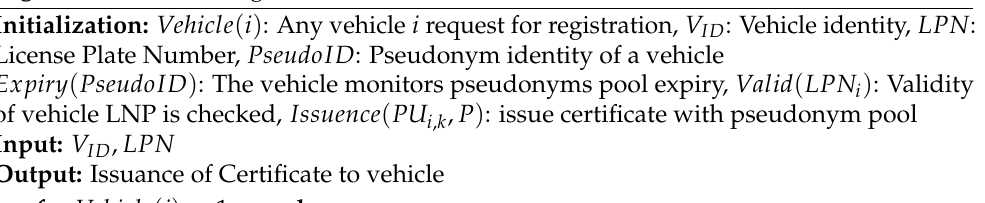
Algorithm 1 Vehicle